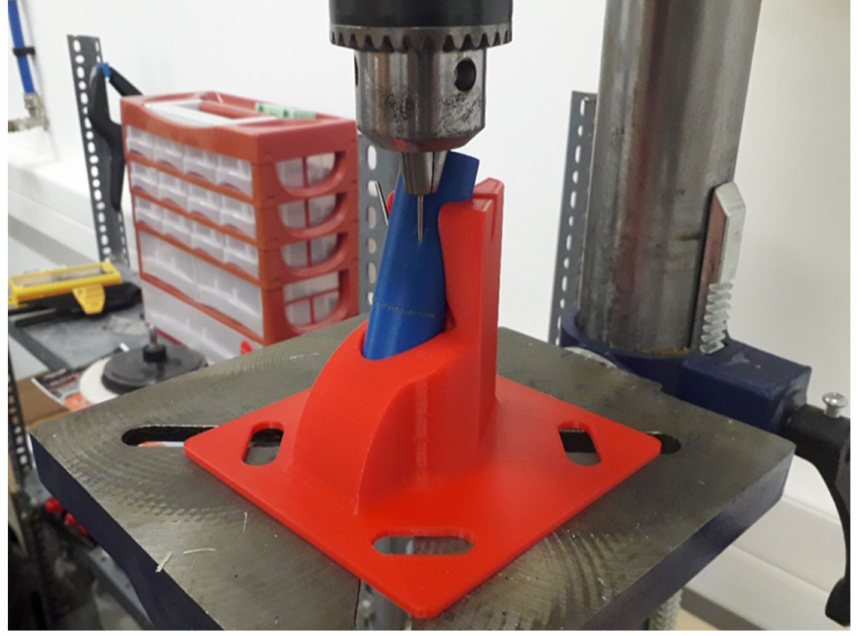
Figure 2. The insertion of the K-wires was mechanized by an Einhell BT-BD 701 stand drill.